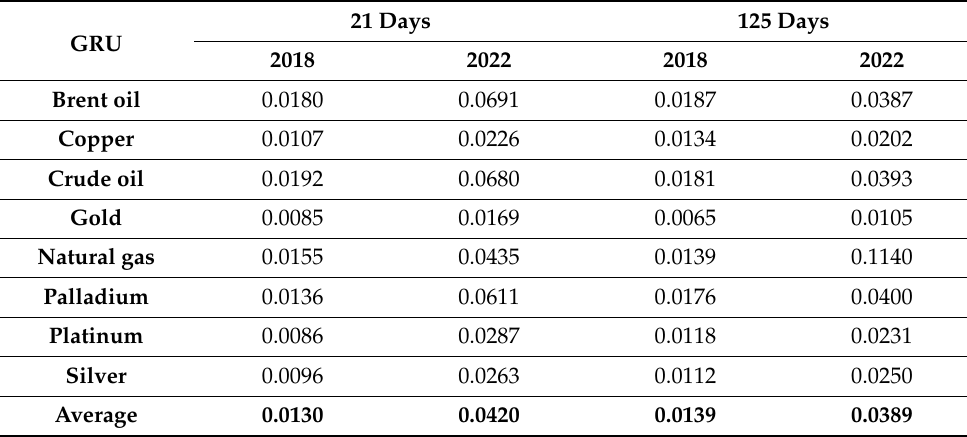
Table 13. Gated Recurrent Unit (GRU) forecast